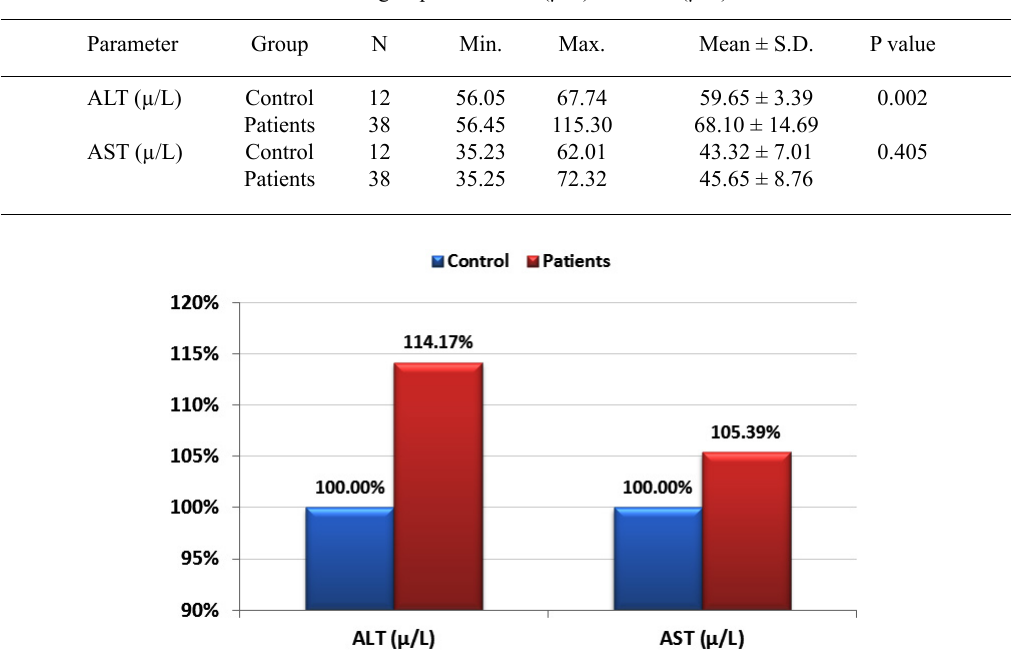
table 1. The independent T-Test between Control and Patients groups in all ALT (µ/L) and AST